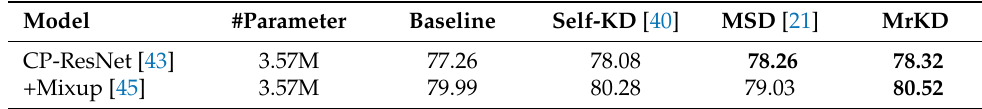
Table 7. Test accuracy comparison on DCASE’18 acoustic scene classification (ASC) [30] dataset. Model